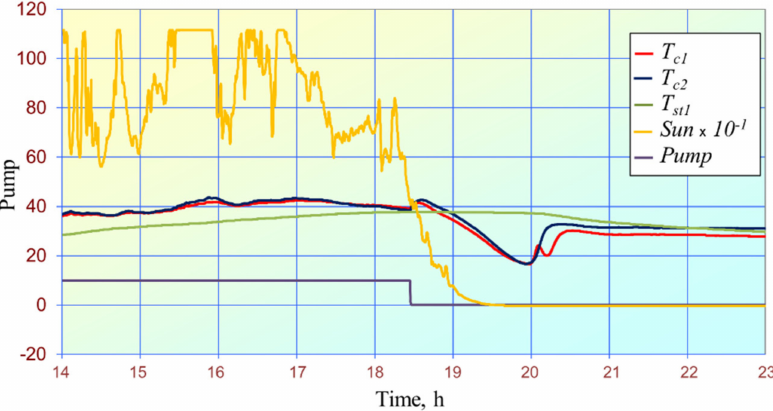
Figure 17. Natural convection in the hydraulic circuit with an open solenoid valve (1 April